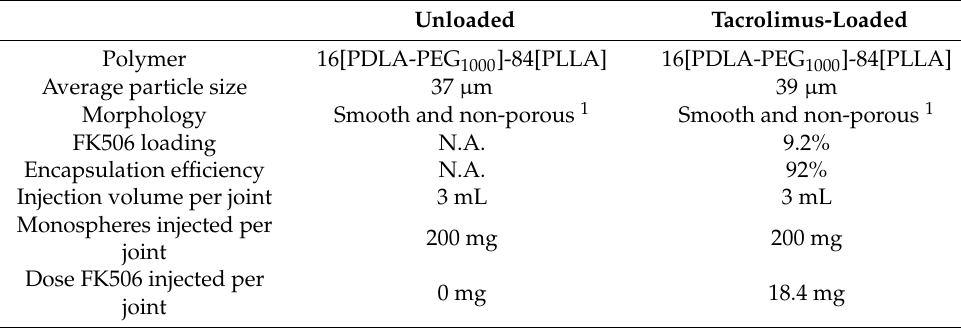
Table 1. Overview of the monospheres with their